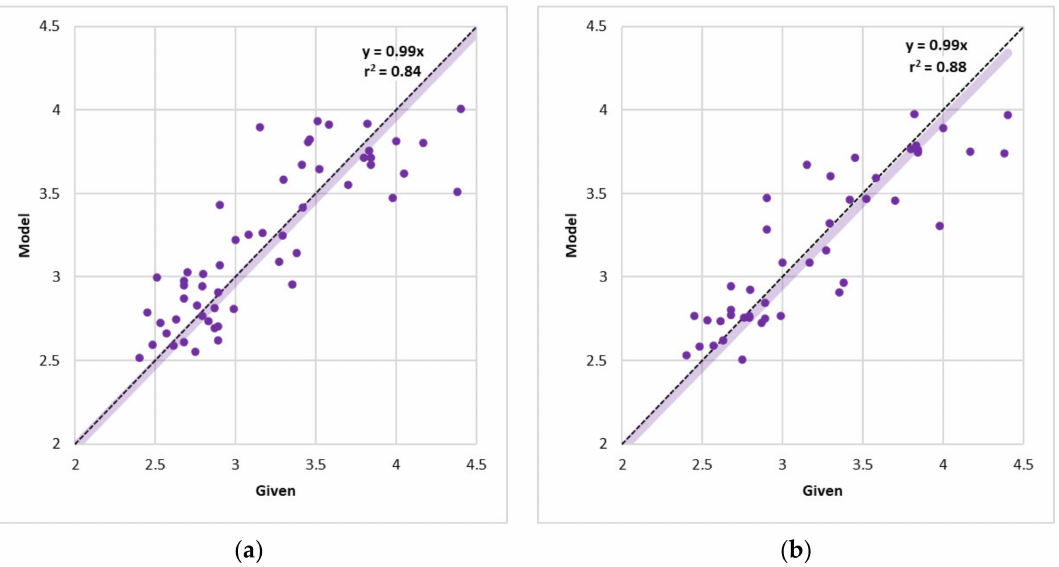
Figure 22. Plot of given and modelled pH values in acidic to weakly acidic water bodies based on Sentinel-2 ( a ) Level-1C TOA and ( b ) Level-2A BOA products. The correlation between Sentinel-2 bands and pH values in acidic to weakly acidic water bodies may be well-explained by the linear dependency between dissolved iron concentration and pH values, which was discussed in Section 2.1. As a result, the surface reflectance patterns of Fe 3+ concentration influence the good result obtained in acidic to weakly acidic